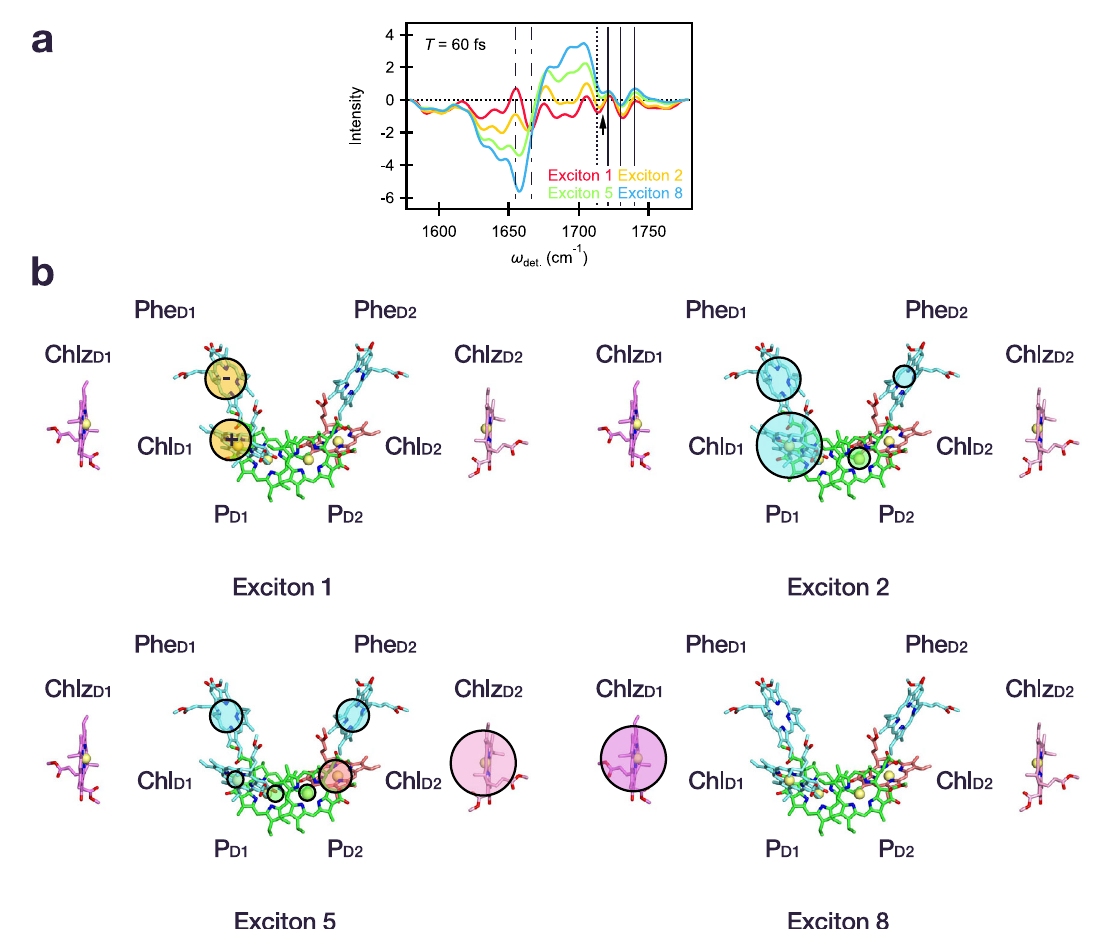
Fig. 3 Assignment of excitonic composition and charge transfer character. a Slice along ω det. of the 2DEV spectrum corresponding to exciton 1 (red, integrated at ω exc. = 14,500 – 14,650 cm − 1 ), exciton 2 (yellow, ω exc. = 14,690 cm − 1 ), exciton 5 (green, ω exc. = 14,850 cm − 1 ), and exciton 8 (blue, ω exc. = 14,940cm − 1 ) at a waiting time of 60 fs. The vertical solid, dotted, and dash-dotted lines, as well as the black arrow follow the same convention as in Fig. 2. b Character of initial charge transfer state, exciton 1, along with the site contributions of excitons 2, 5, and 8 where the area of the shaded circles is proportional to the population of the corresponding sites based on the model of Novoderezhkin et al. 34 . For clarity, the slight, additional contributions from D1 pigments, nearly identical to the relative contributions of exciton 2, were omitted from exciton 1. Likewise, the charge transfer character present in excitons 2 and 5 was excluded for